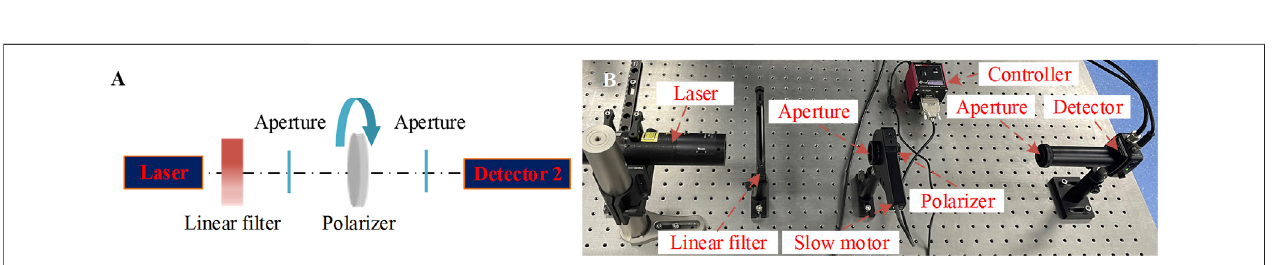
FIGURE 3 | Calibration results of Gaussian additive noise of detector 1 and detector 2.